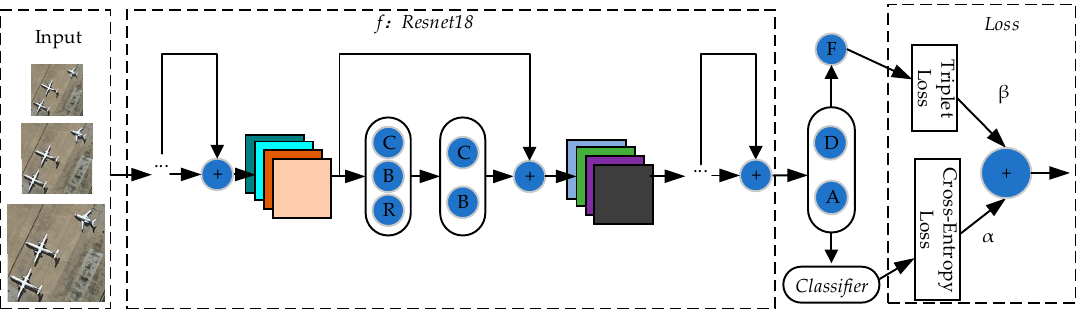
Figure 2. Overall framework. C represents convolution, B represents BatchNorm [42], R represents activation function ReLU [43], and “ + ” represents element-wise additions. D represents dropout. A represents adaptive pooling. F represents the fully connected layer, which serves Triplet Loss. α is the weight of Cross-Entropy Loss, and β is the weight of Triplet Loss.